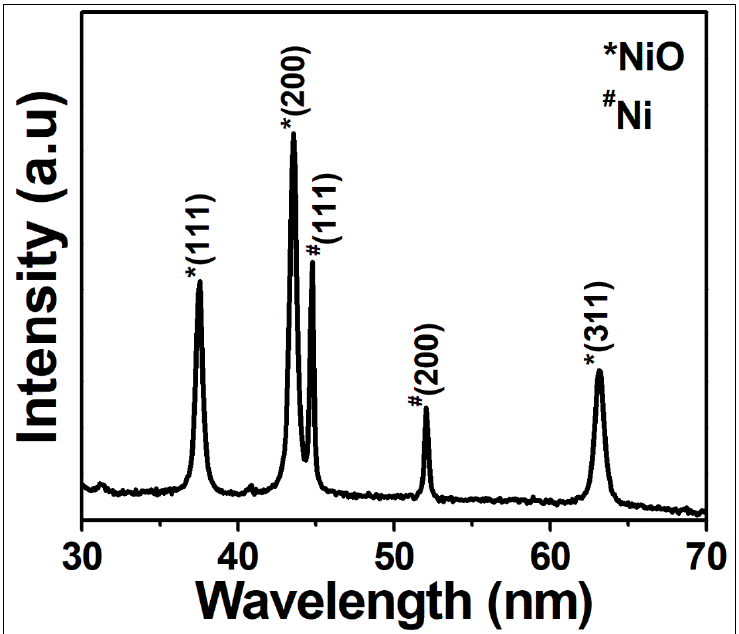
Figure 2. XRD spectrum of Gymnema sylvestre leaves extract mediated biosynthesized Ni/NiO NPs.